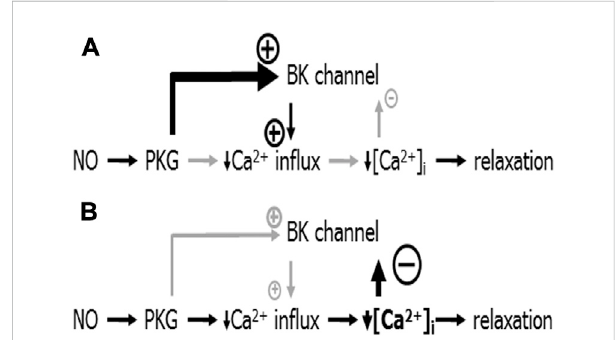
FIGURE 6 Schematic representation of the mechanism of BK channel contributiontotheanti-contractileeffectofSNP. (A) Conditionswhen NO produced only a small decrease in [Ca 2+ ] i : NO induces a PKG- mediated activation of the BK channel that is stronger than the small [Ca 2+ ] i -decrease-mediated deactivation of the BK channel. The overall effect of both is an activation of the BK channel contributing to the reduction of calcium in fl ux; BK channels facilitate NO-induced vasodilation. (B) Conditions when NO produced a considerable decrease in [Ca 2+ ] i : NO induces a PKG-mediated activation of the BK channel that is weaker than the large [Ca 2+ ] i -decrease-mediated deactivation of the BK channel. The overall effect of both is a deactivation of the BK channel opposing the reduction of calcium in fl ux; BK channels limit NO-induced vasodilation. Reproduced and modi fi ed with permission from (Schmid et al.,